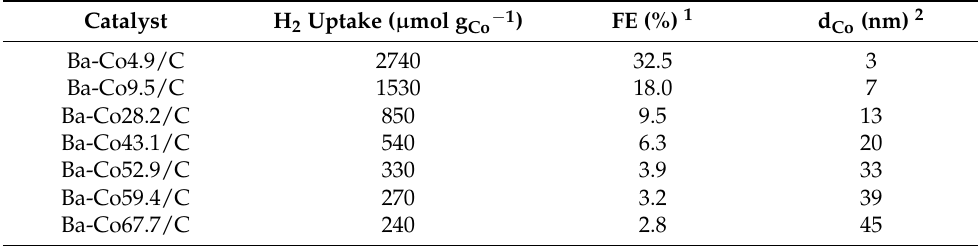
Table 2. Chemisorptive characteristics of the Ba-Co/C catalysts.